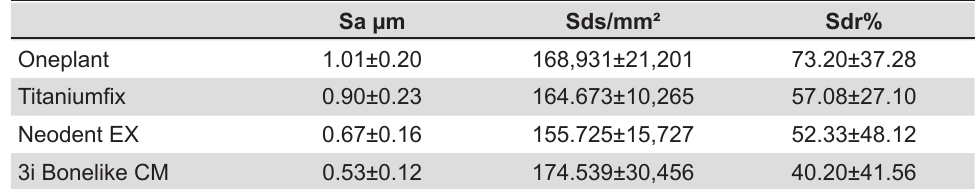
Table 1- Numerical description of the surface at a micrometer